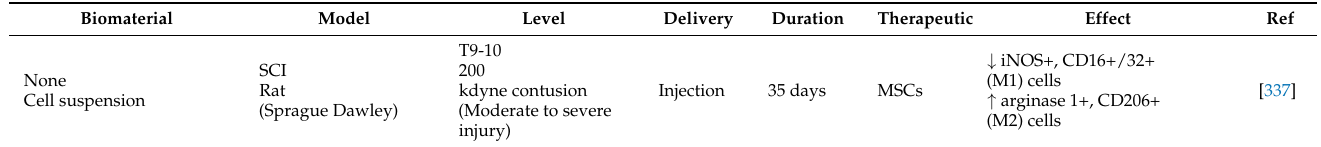
Table 7. Summary of the different types of stem cell used to treat CNS injury and their effect on macrophage number and phenotype in the lesion site. Where ↑ indicates an increase in specific cells population and ↓ indicates a decrease in specific cell